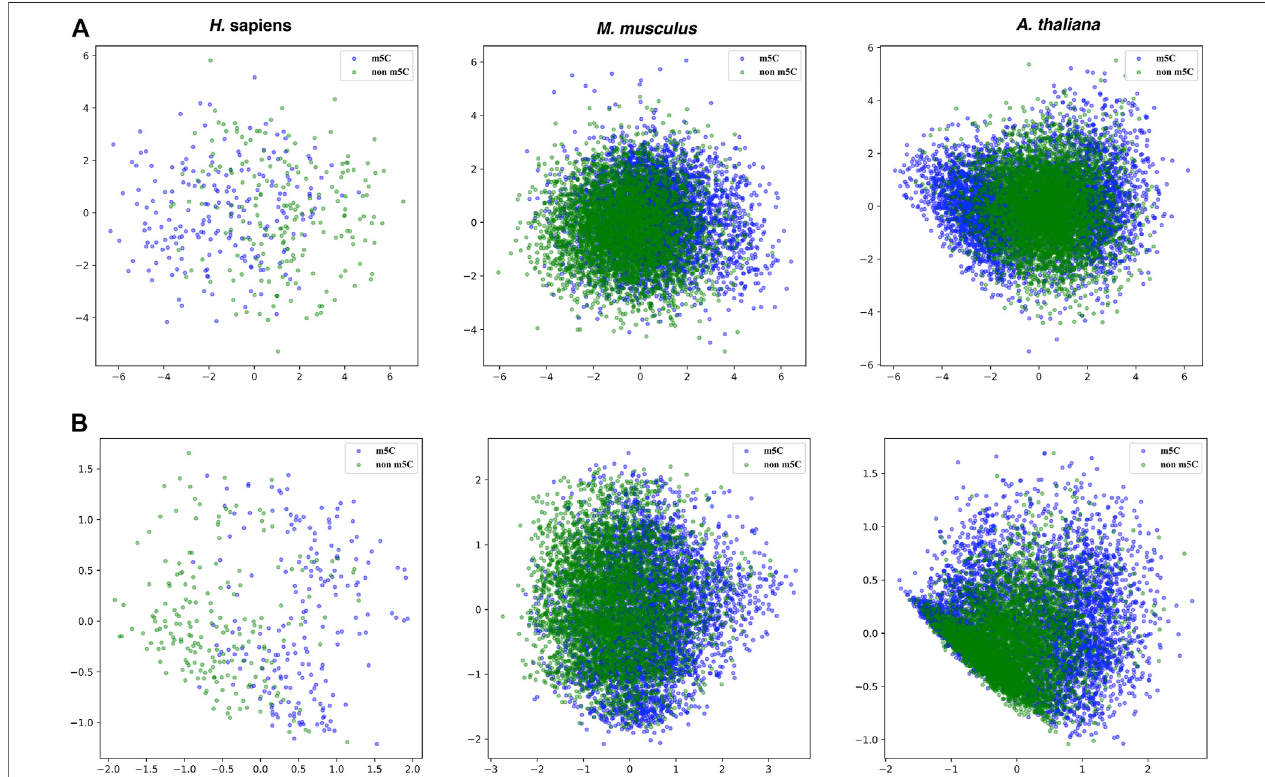
FIGURE 6 | PCA plots for the original 808 dimensional features and features selected by SHAP for the three species. Upper panel: the original 808 dimensional features; Lower panel: the features selected by SHAP.